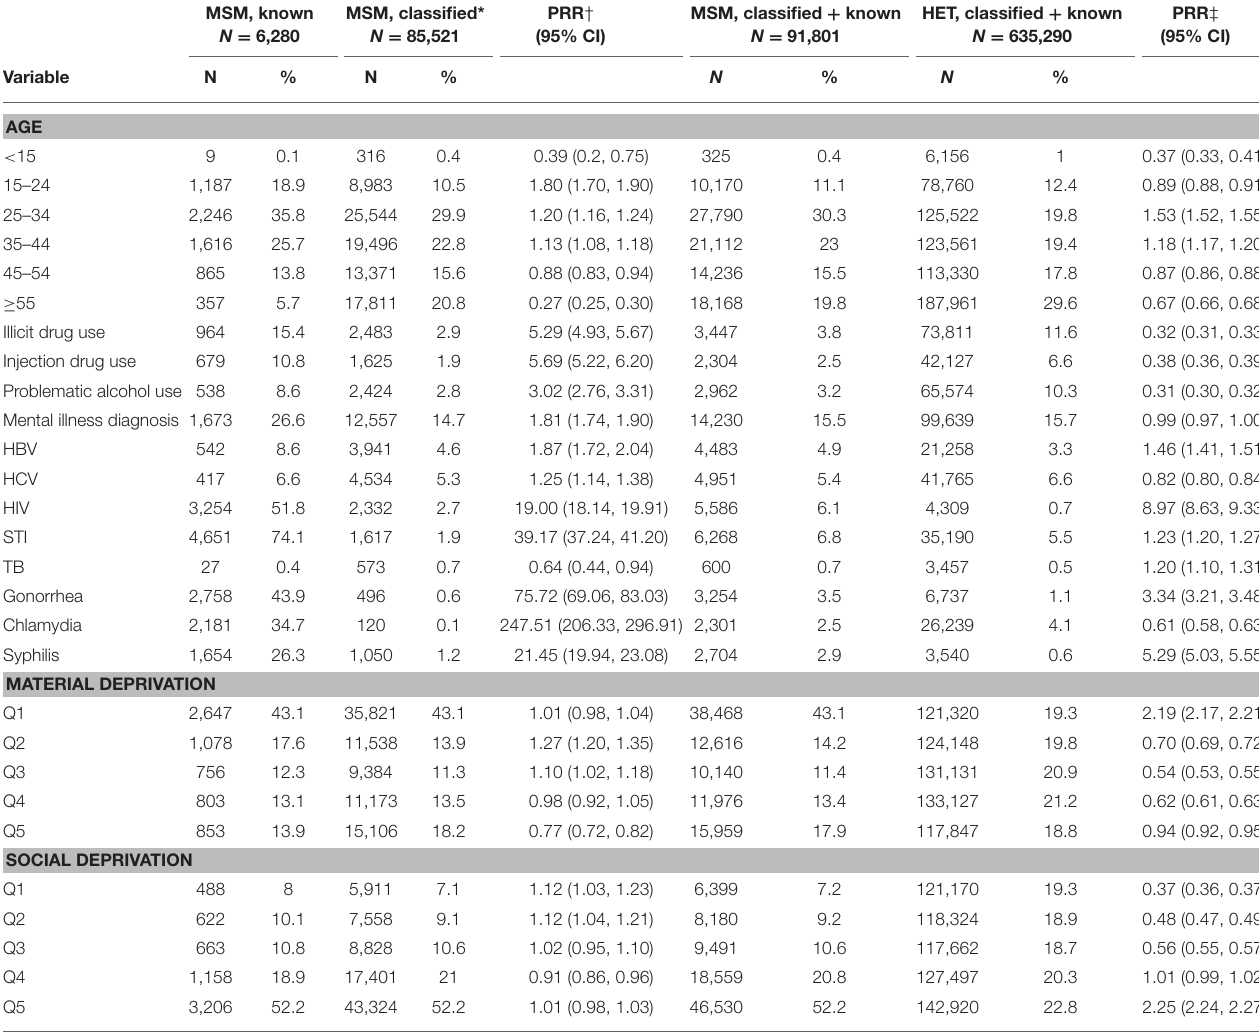
TABLE 3 | Characteristics of known and classified men who have sex with men and heterosexual men in the British Columbia hepatitis testers